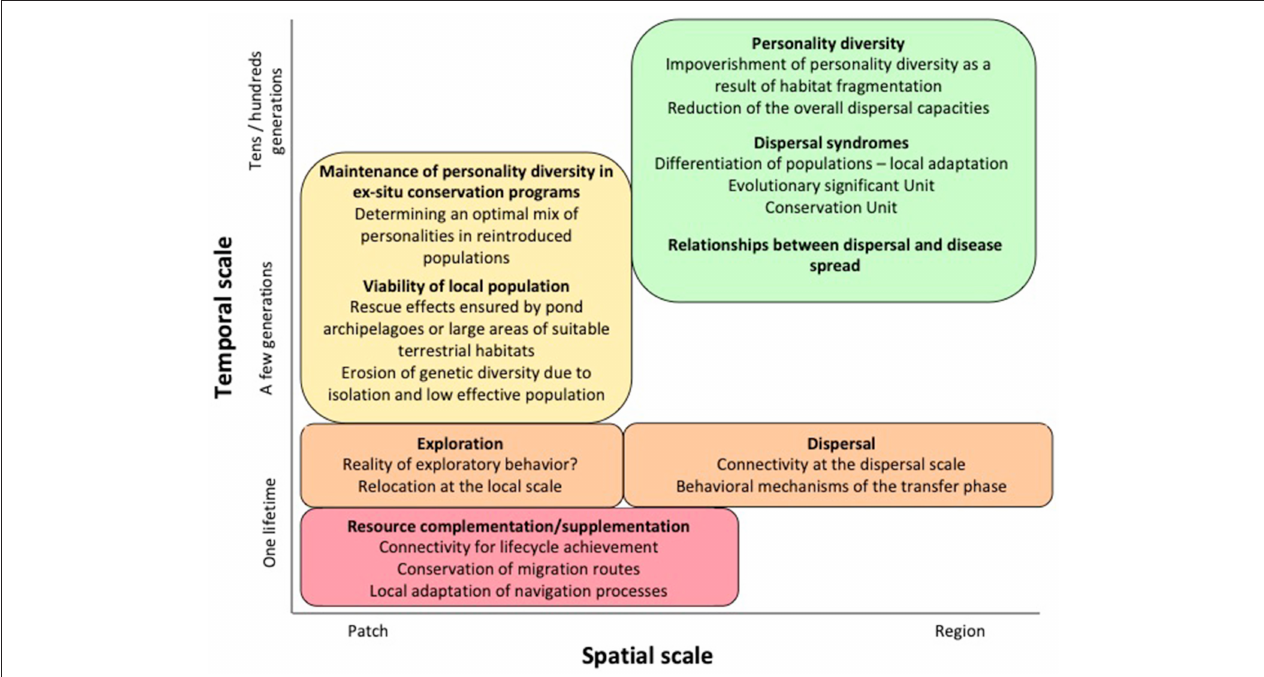
FIGURE 3 | Aspects of amphibian movement ecology at different spatial and temporal scales that need to be better understood for conservation planning.